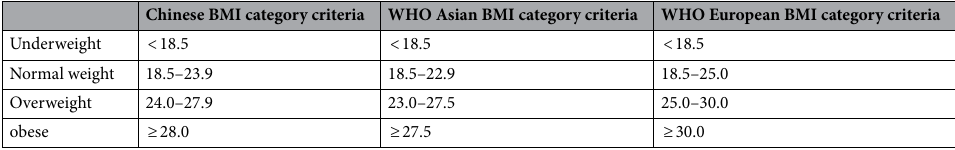
Table 5. Classifications of Body mass index (BMI). BMI body mass